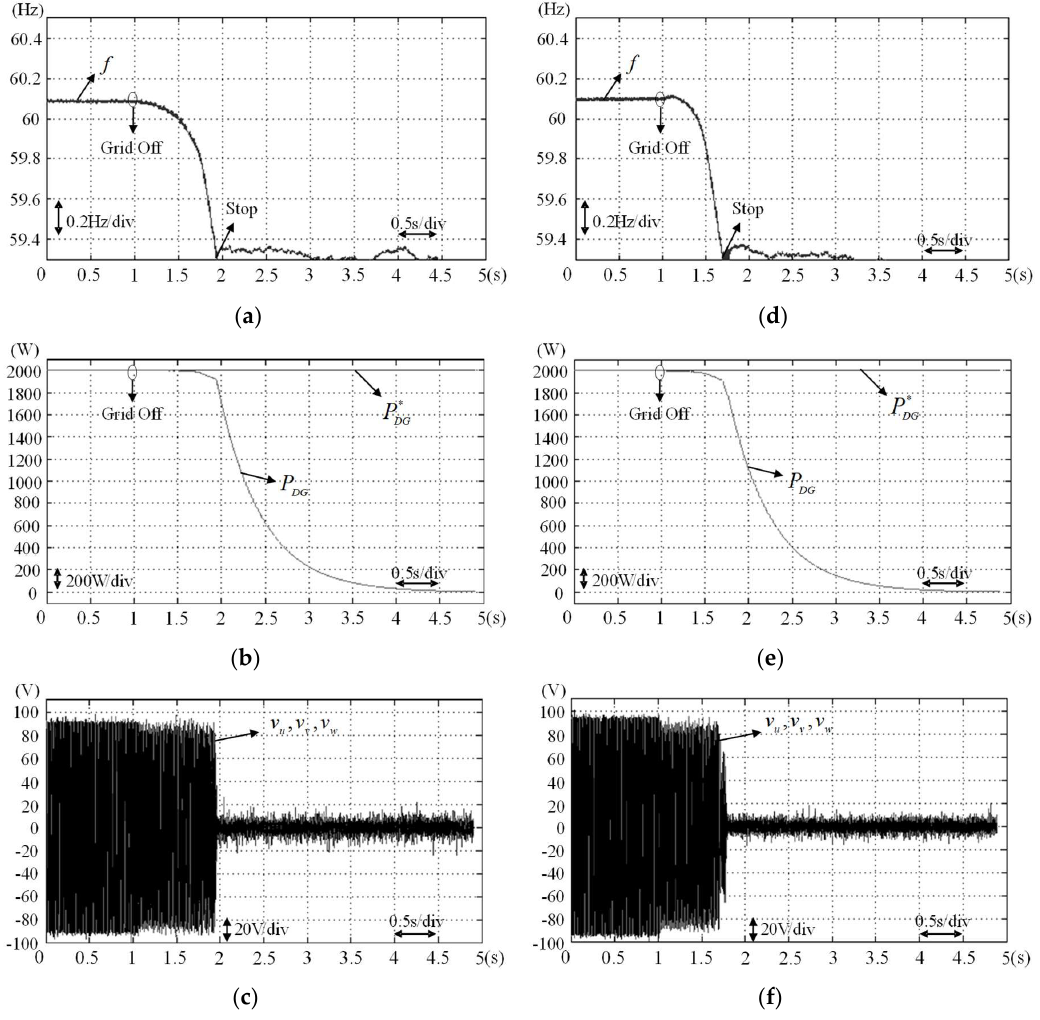
Figure 10. Experimental results of proposed active islanding detection method at case 3: ( a ) Frequency